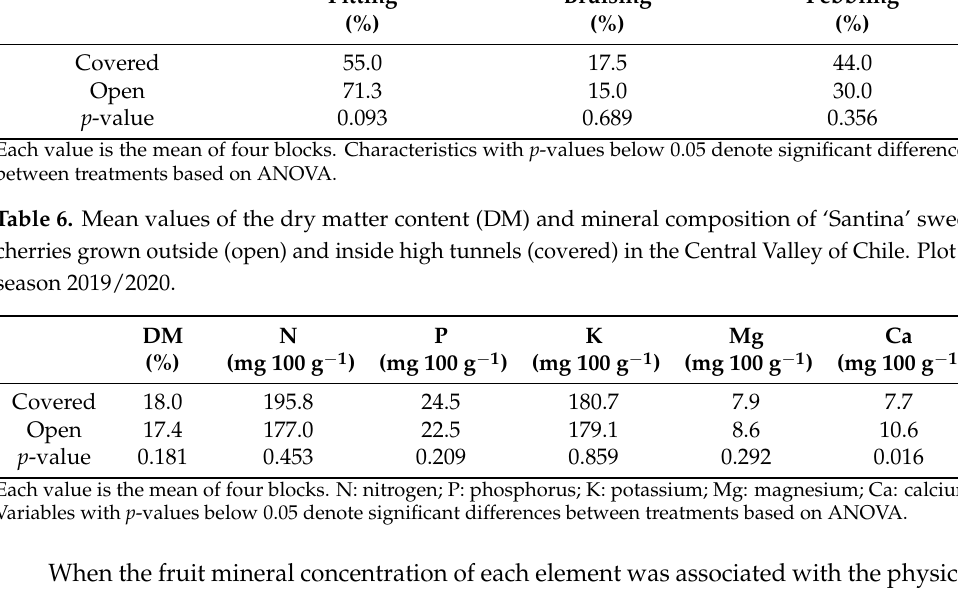
Table 5. Mean values for physiological storage disorders of ‘ Santina ’ sweet cherries grown under high tunnels (covered) or in the open in the Central Valley of Chile. Plot 1, growing season 2018/2019, after 45 days of cold storage and 3 days of shelf life.